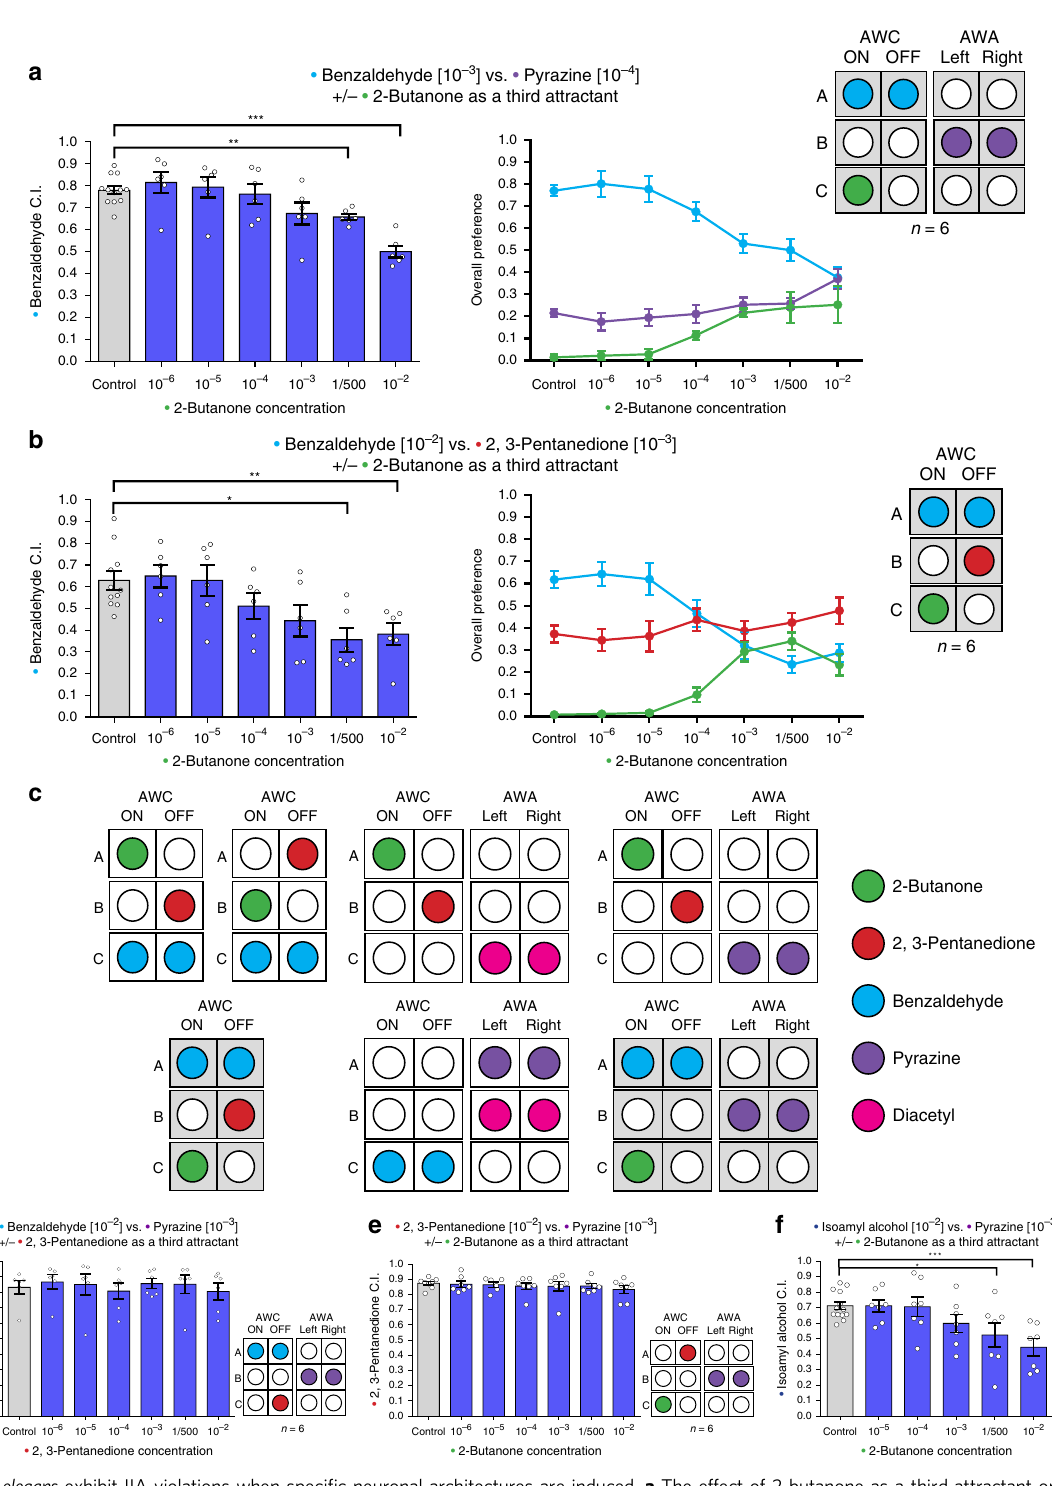
Fig. 2 C. elegans exhibit IIA violations when speci fi c neuronal architectures are induced. a The effect of 2-butanone as a third attractant on the relative preference between benzaldehyde and pyrazine, and the overall preference of each attractant point in every condition (two-tailed Wilcoxon signed-ranks test, C = 1/500: W = 2, q = 0.0012; C = 10 − 2 : W = 0, q = 0.0006; n = 6). b The effect of 2-butanone as a third attractant on the relative preference between benzaldehyde and 2,3-pentanedione, and the overall preference of each attractant point in every condition. (two-tailed Wilcoxon signed-ranks test, C = 1/500: W = 6, q = 0.0144; C = 10 − 2 : W = 2, q = 0.0036; n = 6). c In all the violations that we described so far, 2-butanone, sensed speci fi cally by the AWC ON neuron, functioned as odor C, and benzaldehyde, sensed by both AWC neurons, functioned as odor A. d 2,3-pentanedione as a third attractant does not change the relative preference between benzaldehyde and pyrazine (two-tailed Wilcoxon signed-ranks test, n = 6). e 2-butanone as a third attractant does not change the relative preference between 2,3-pentanedione and pyrazine (two-tailed Wilcoxon signed-ranks test, n = 6). f 2-butanone as a third attractant signi fi cantly reduced the relative preference for isoamyl-alcohol over pyrazine (two-tailed Wilcoxon signed-ranks test, C = 1/500: W = 14, q = 0.0278; C = 10 − 2 : W = 2, q = 0.0005; n = 7). Bars represent the C.I. of odor A. Error bars represent the standard error of the mean C.I. * q <0.05, ** q <0.01, *** q <0.001, **** q